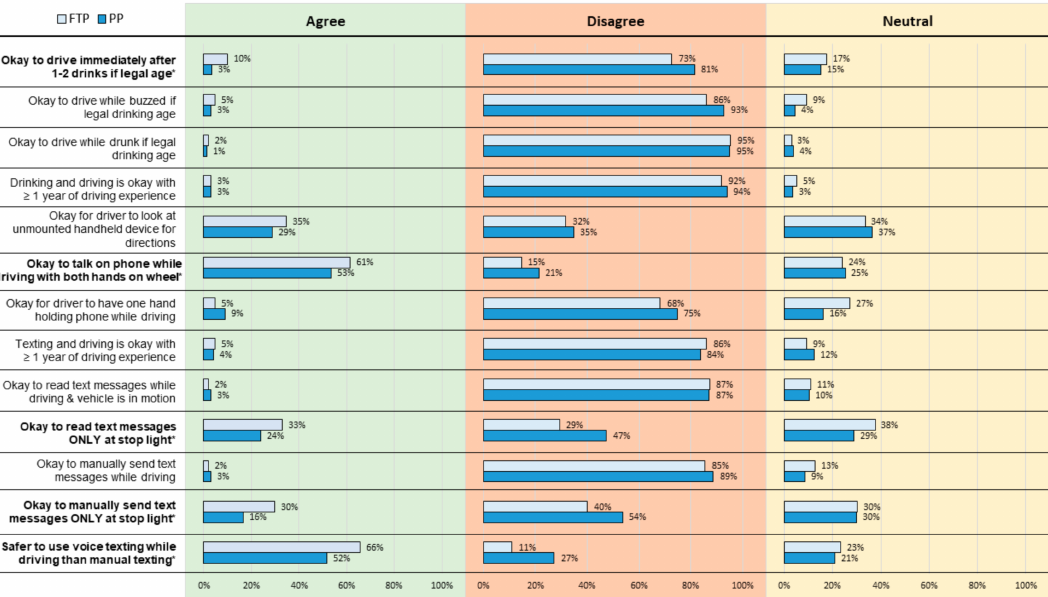
Figure 3. Attitudes of driving behaviors among first-time participants (FTP) and previous participants (PP). Statements in bold * are statistically significant. p -values < 0.05 are statistically significant. Note: “Agree” and “Strongly Agree” responses were combined; “Disagree” and “Strongly Disagree” were also combined. The percentages shown in the figure are rounded up to the nearest